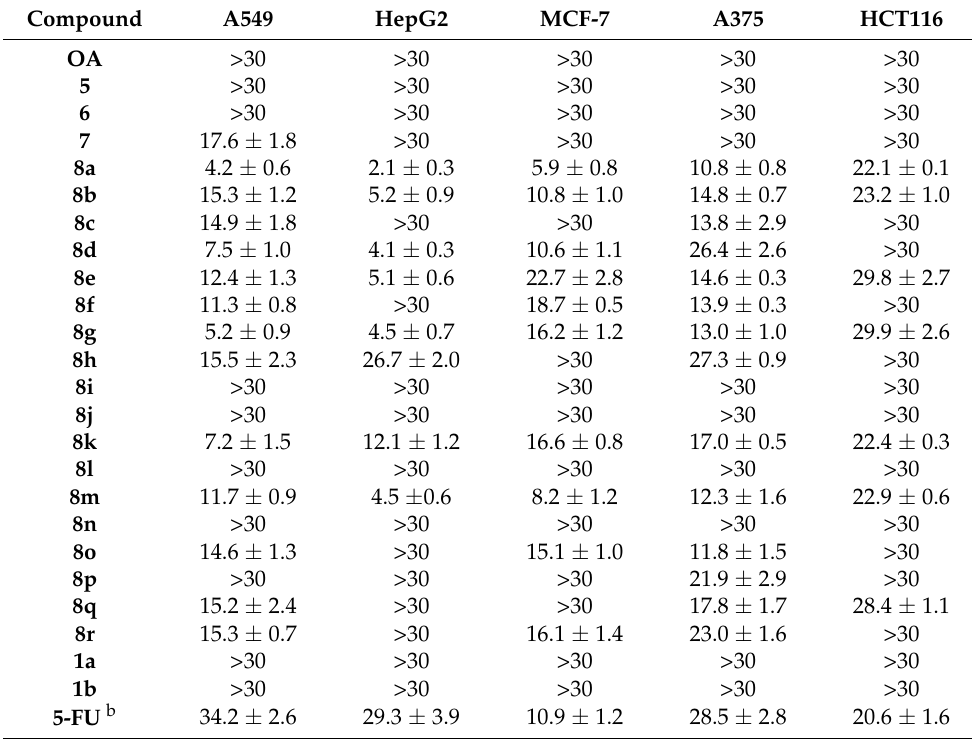
Table 2. IC 50 ( µ M) a values of neoaglycone 7 and neoglycosides 8a–8r against five human cancer cell